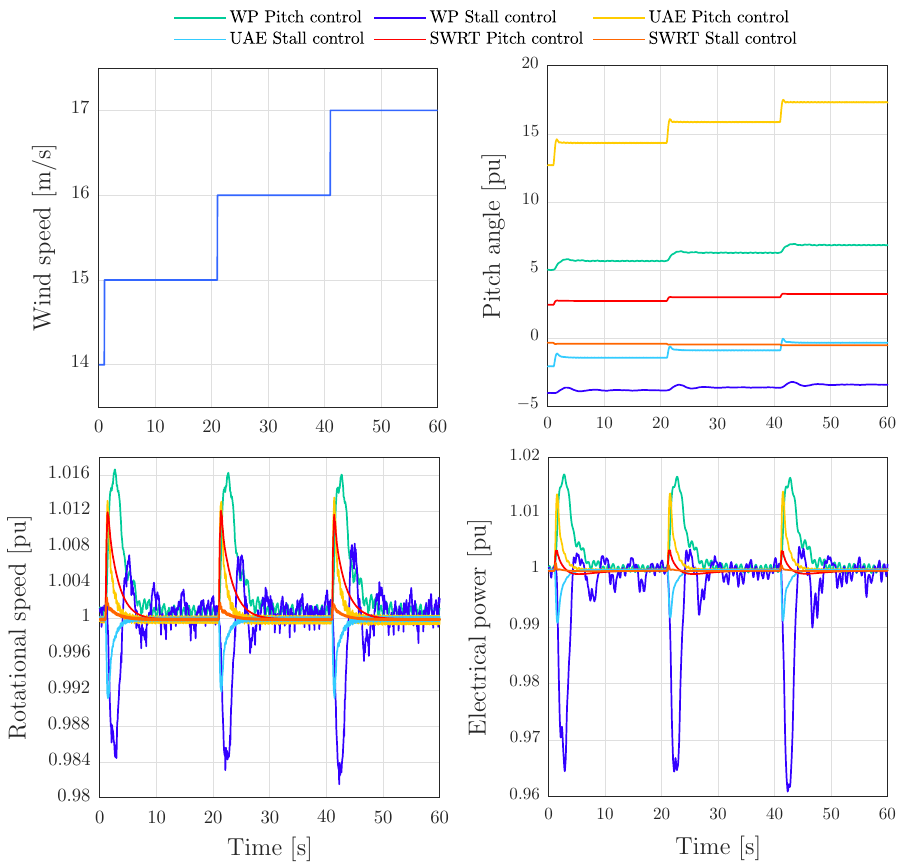
Figure 8. Dynamic performance of the SWRT, UAE, and WP wind turbines in the high wind